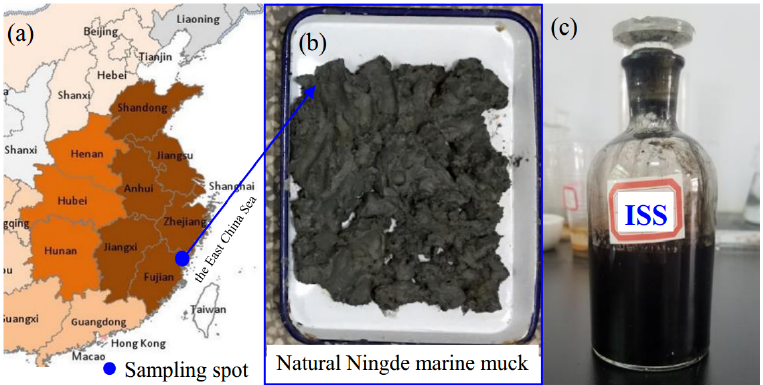
Figure 1. Test materials: ( a ) Sampling spot; ( b ) Natural marine muck from Ningde; ( c ) Ionic soil stabilizer